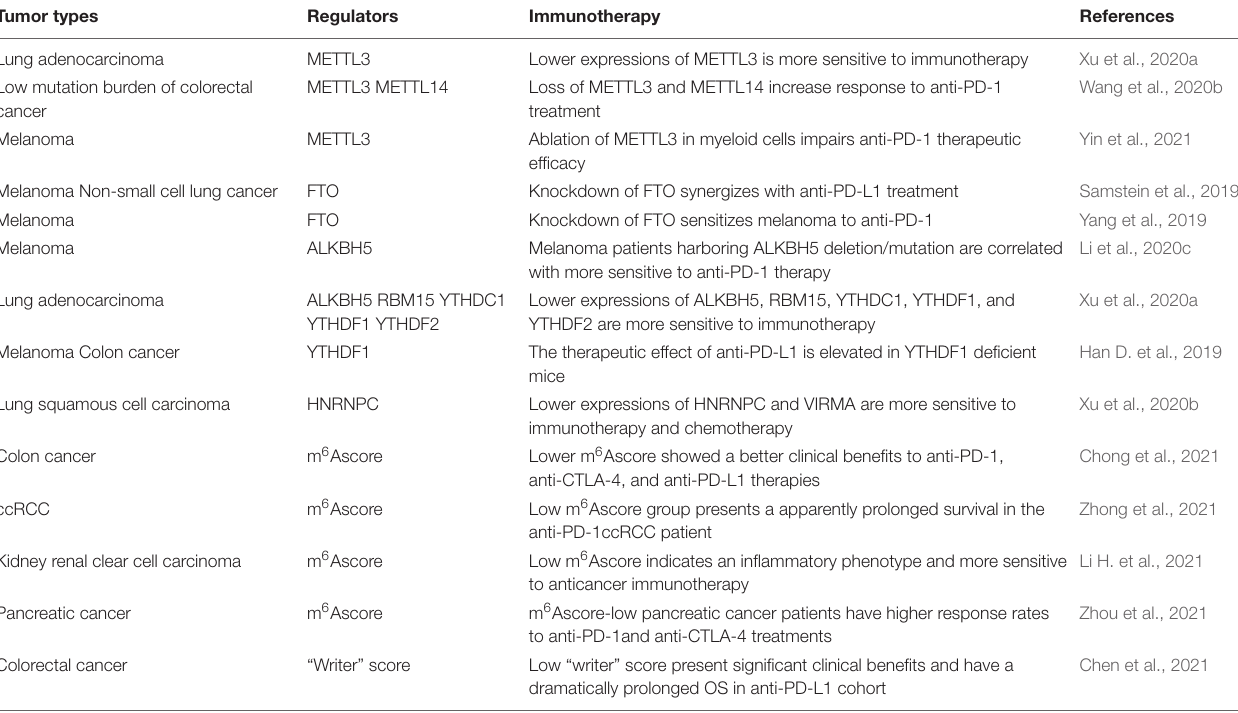
TABLE 3 | Targeting RNA m 6 A modification as cancer